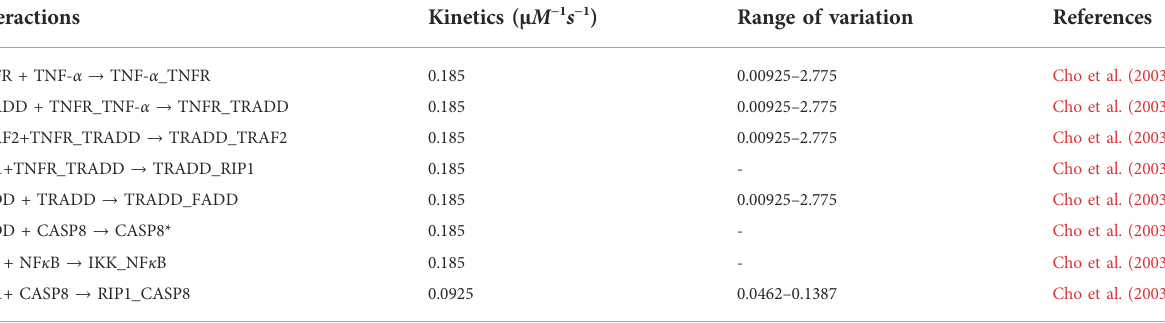
TABLE 1 Interactions with their Kinetic Parameters (concentration in μ M and time in seconds) from Literature along with corresponding range of variation.